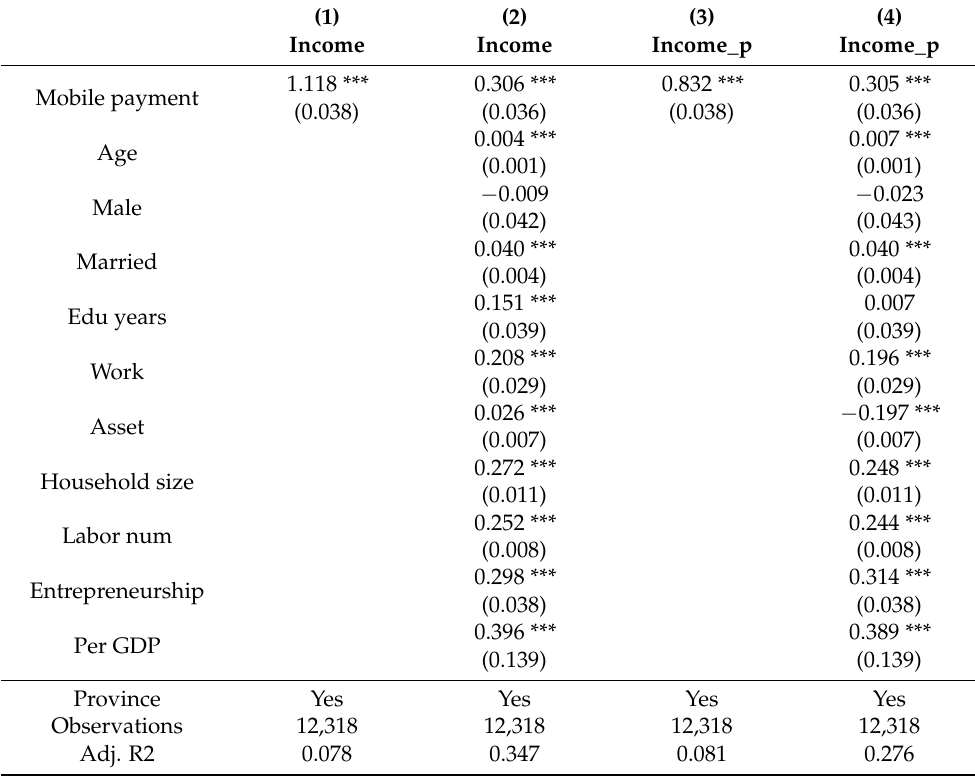
Table 4. The impact of mobile payment on rural household income: the OLS Model.